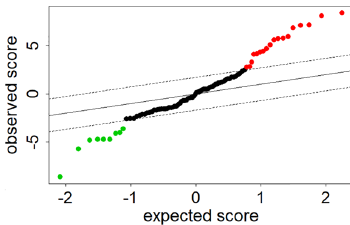
Figure 4. Significance analysis of microarrays for a comparison of patients with GC and healthy individuals in training set at false discovery rate of zero. The levels of 9 metabolites were significantly decreased, and 18 metabolites were significantly increased in patients with GC compared to healthy